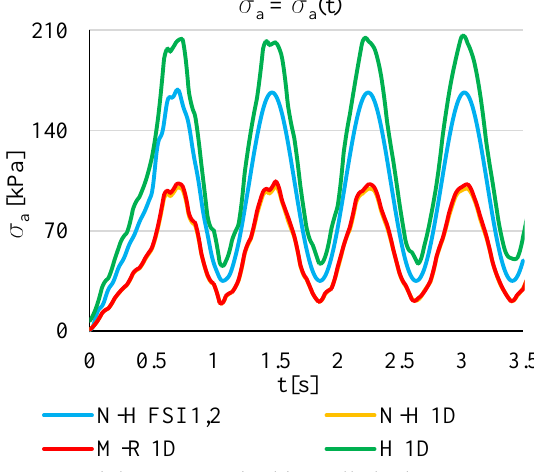
Fig. 13. Circumferential stresses σ t1 and σ t2 in thick- walled tube.